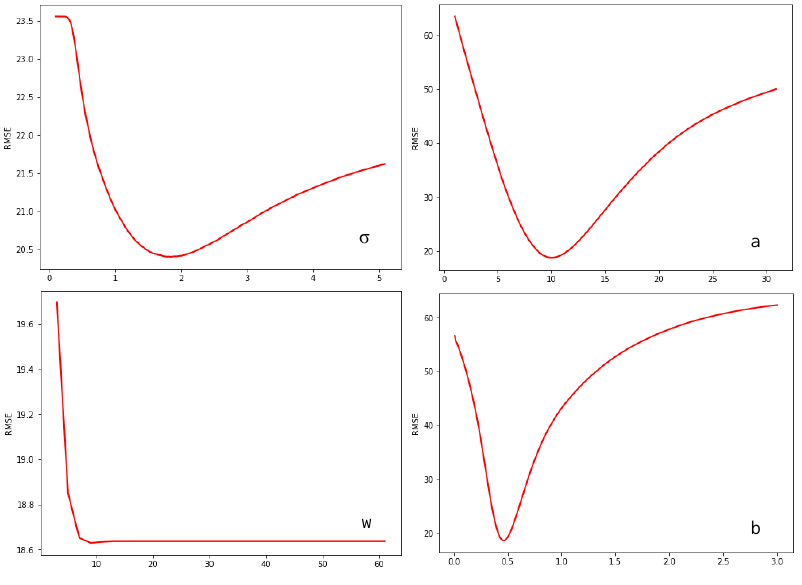
Figure 8. Sensitive analysis of parameters.